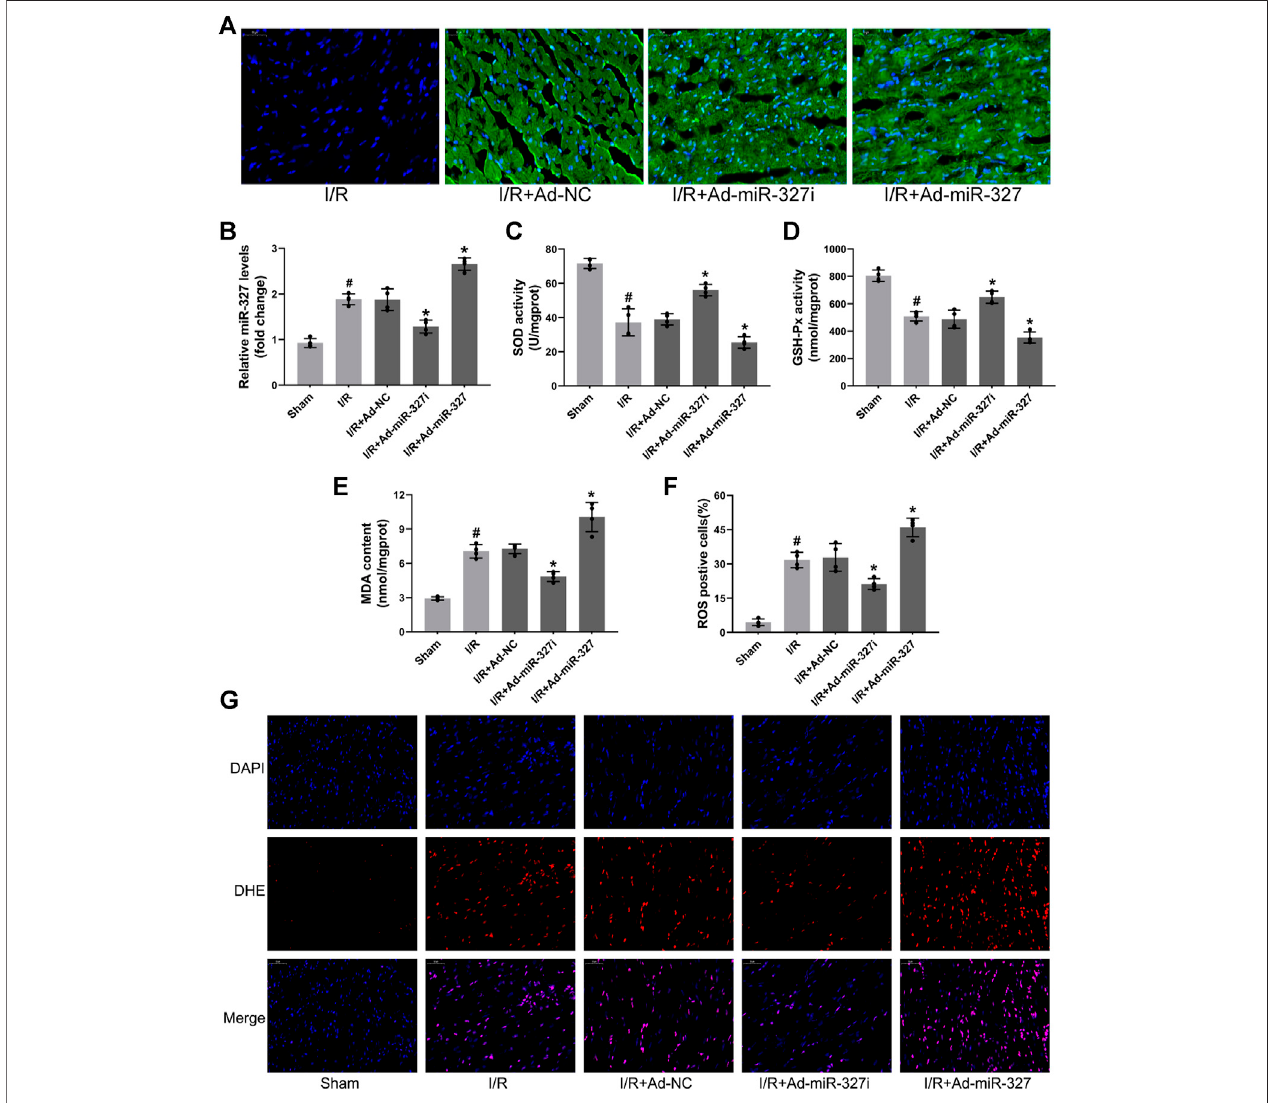
FIGURE 8 | Effects of miR-327 on oxidative stress in MI/RI rats. Representative images of immuno fl uorescence microscopy after transfection of recombinant adenovirus or NS injection, DAPI-labeled nuclei of cardiomyocytes (blue), EGFP(green) and merged (A) . Relative expression of miR-327 in MI/RI rats (B) . The levels of SOD (C) , GSH-Px (D) , and MDA (E) in heart tissues of MI/RI rats. DHE staining for detecting intracellular ROS generation in heart tissues of MI/RI rats (G) in each group, and the analysis of ROS positive cells by Image-ProPlus (F) . Data are expressed as the mean ± SD ( n (cid:2) 4); # p < 0.05 versus the Sham group; * p < 0.05 versus the Ad-NC